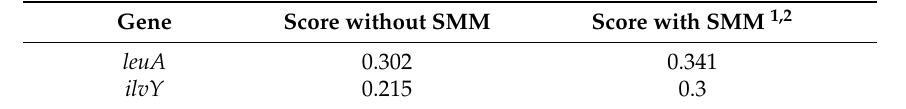
Table 4. Sulfometuron methyl resistant gene hits, involved in the synthesis of amino acids, normalized to include only the effects of Ga exposure; only those with a score two deviations from the mean are